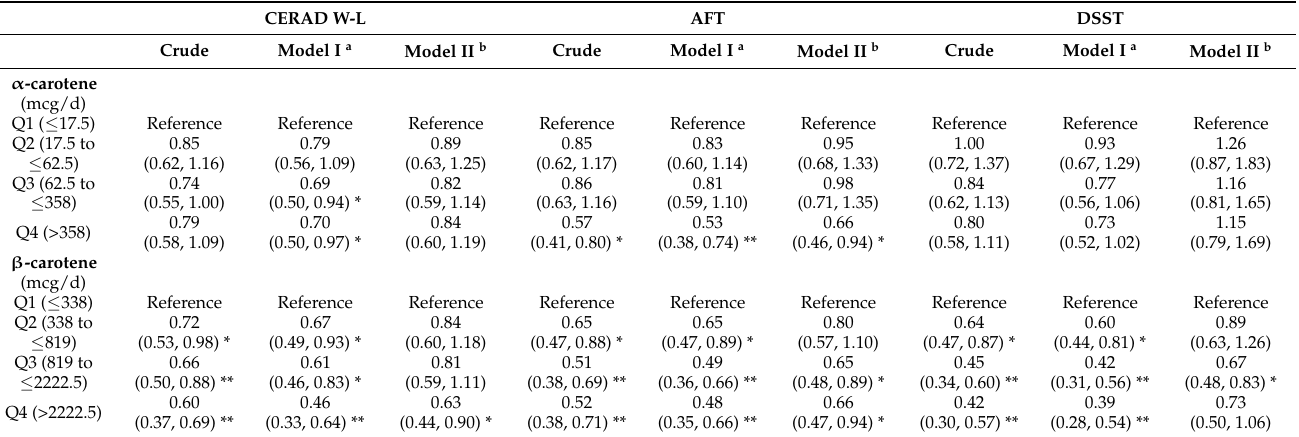
Table 2. Weighted odds ratio (95% confidence intervals) of low cognitive performance by quartiles of dietary α -carotene and β -carotene